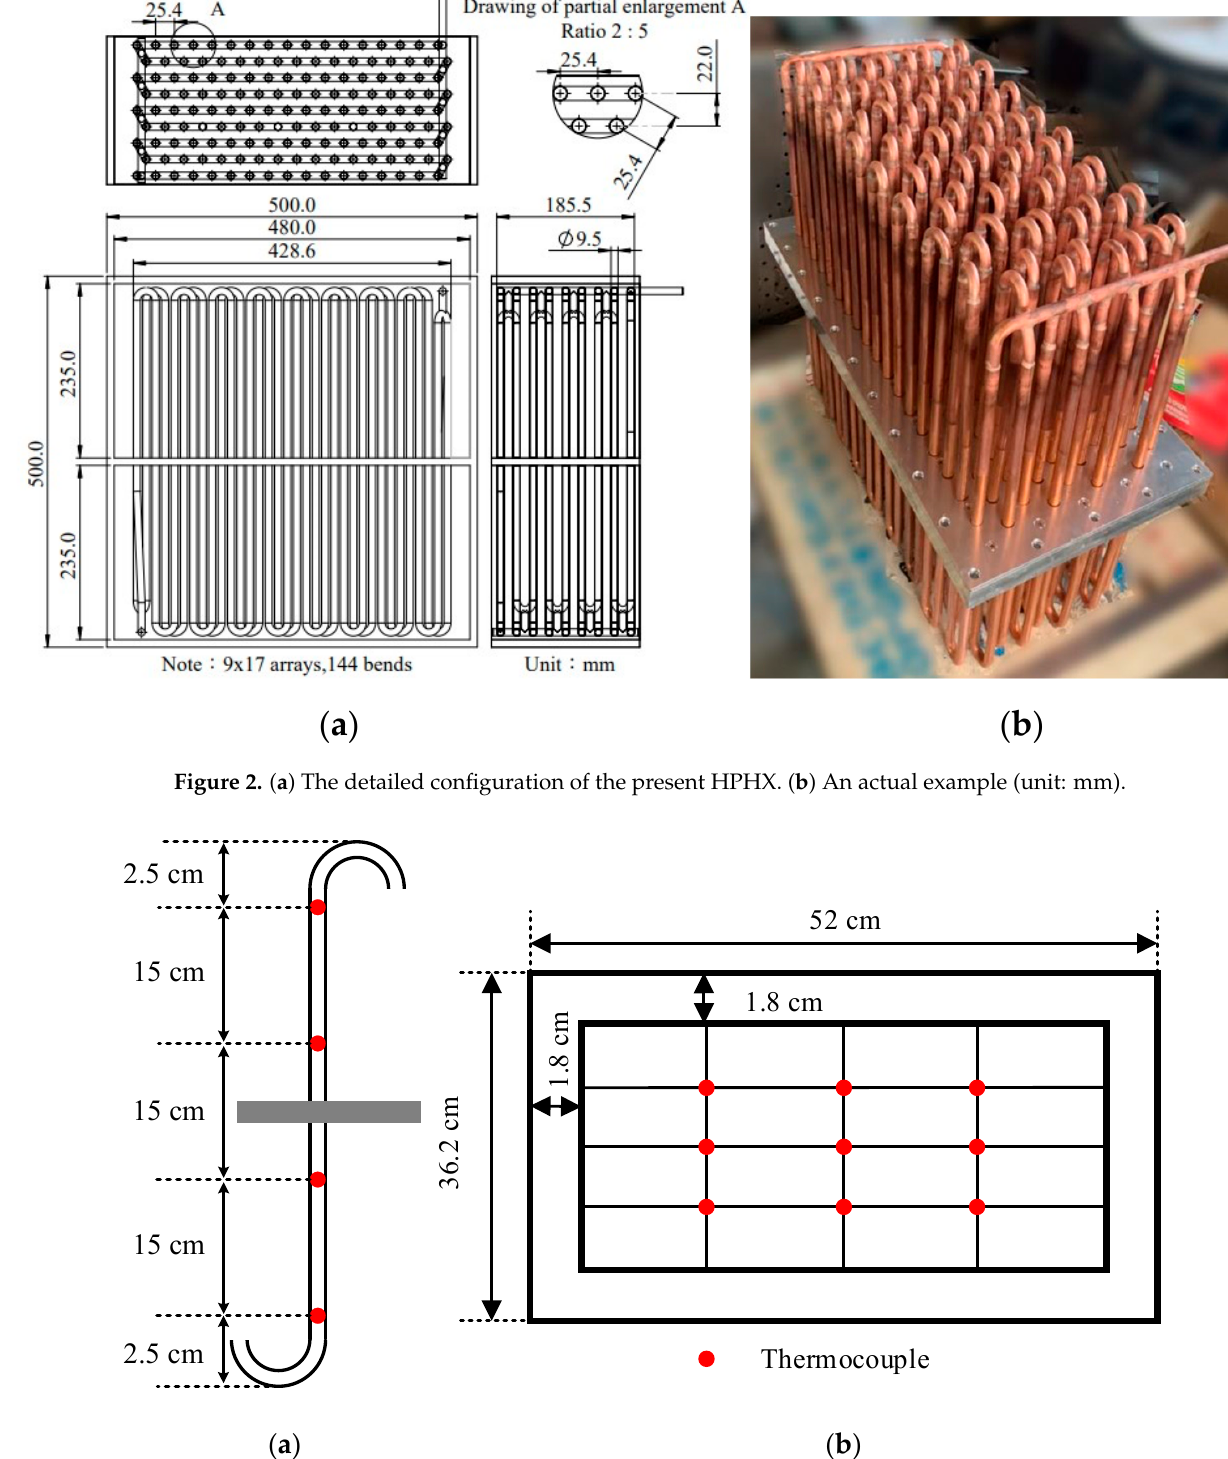
Figure 1. Schematic of the test setup. The indicated thermocouple marks only represent where tem- peratures were measured. A single thermocouple mark may stand for multiple thermocouples.